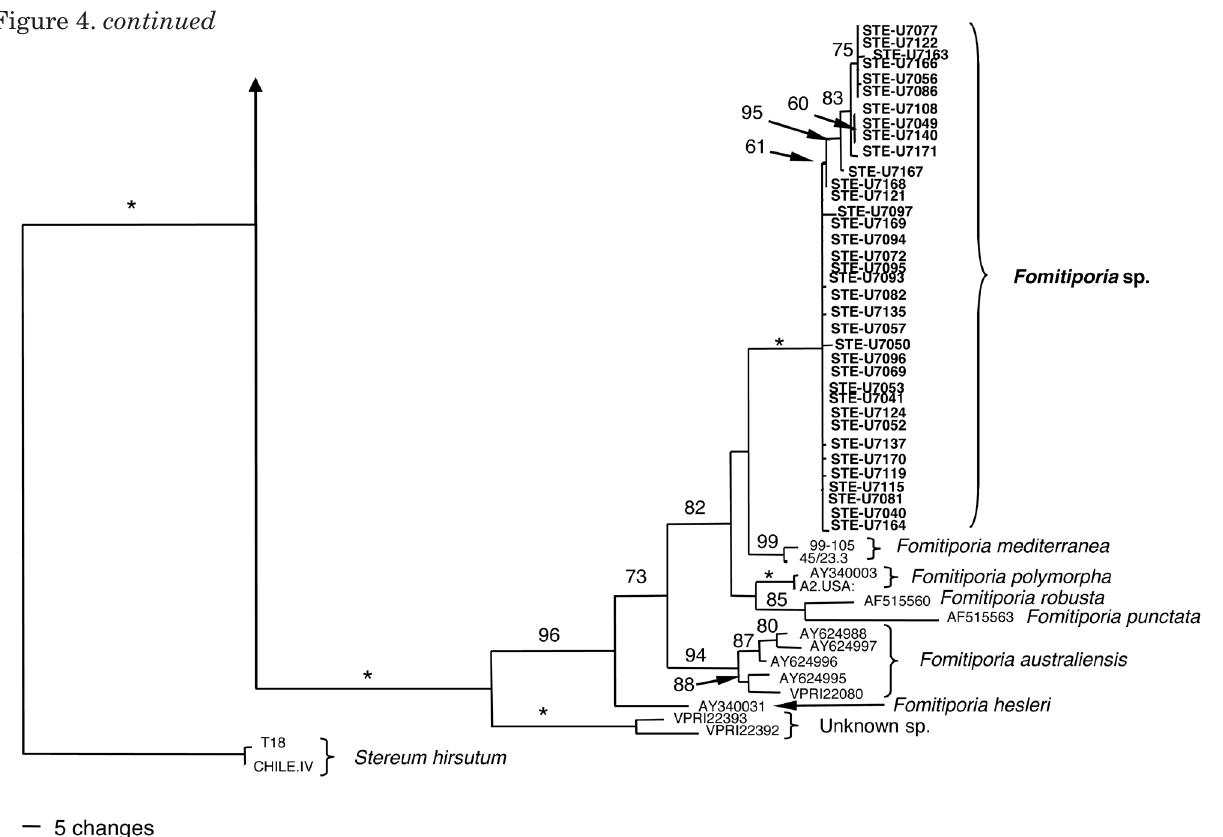
Figure 4. One of ten most parsimonious trees obtained from heuristic searches of the ITS sequences (length: 2050 steps; CI: 0.560; RI: 0.938; RC: 0.526) of basidiomycete isolates. Bootstrap support values are shown above the nodes and bootstrap values of 100% are indicated by an asterisk (*). The outgroups used were Stereum hirsutum isolates T18 and Chile IV. Isolates in bold print are from this